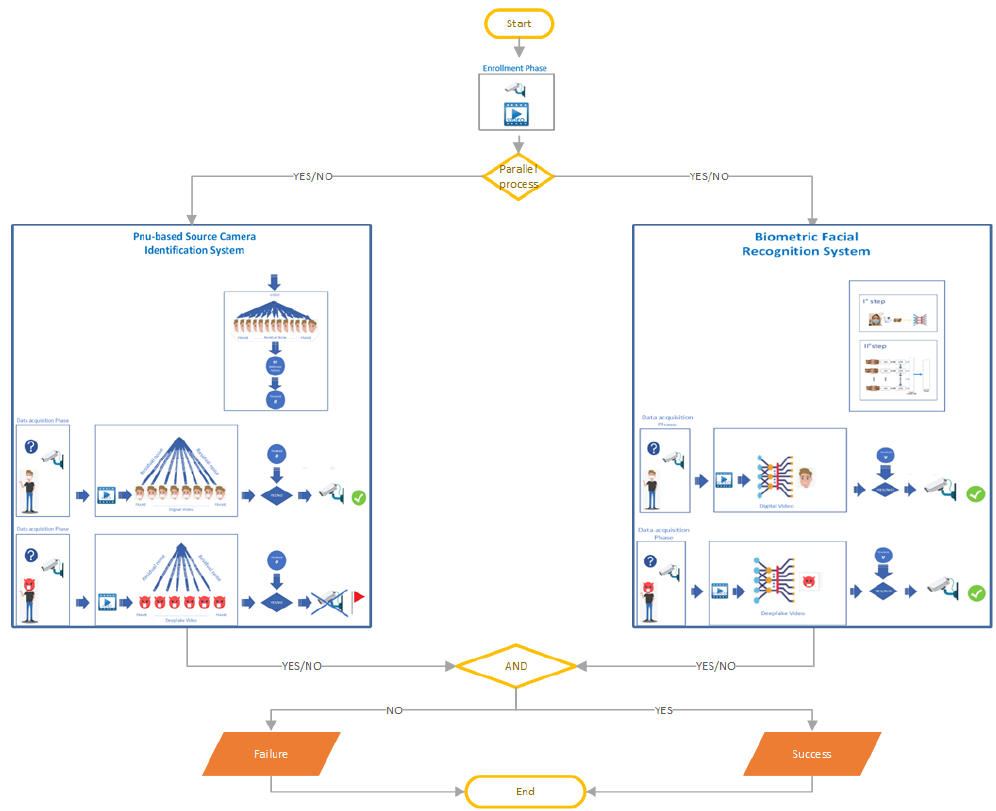
Figure 9. Hybrid PNU-based facial recognition architecture: the left side represents the Pnu-based SCI method and the right side depicts a facial recognition